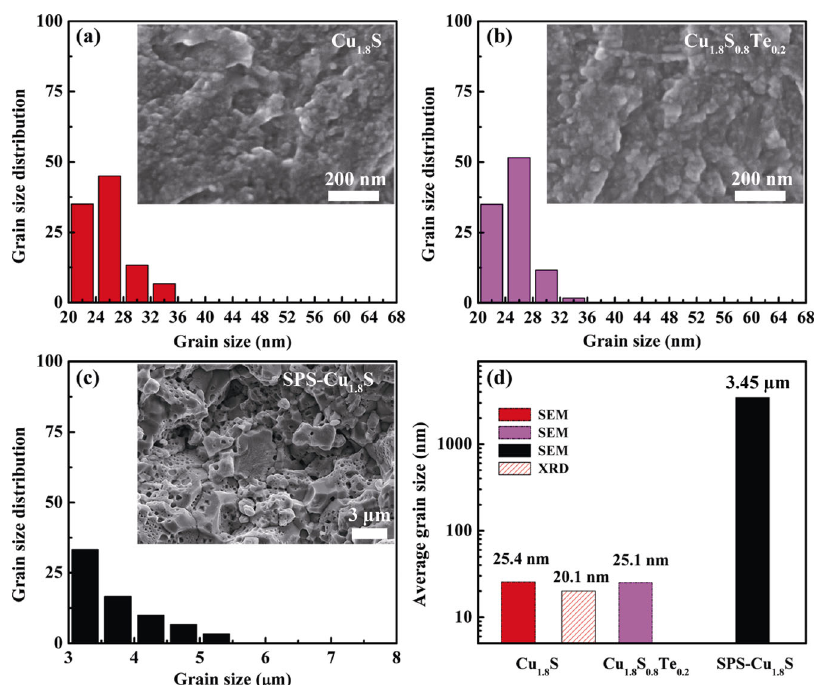
Fig. 2 Grain size distribution of (a) Cu 1.8 S, (b) Cu 1.8 S 0.8 Te 0.2 , and (c) SPS-Cu 1.8 S bulks with SEM images of the fractured surface in the inset. (d) Average grain size from SEM and the calculated one for Cu 1.8 S bulk from